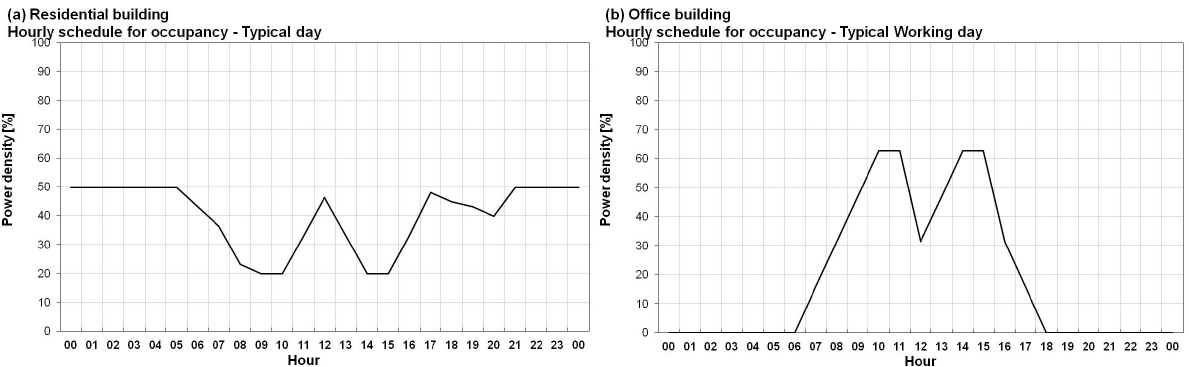
Figure 6. Specific hourly occupancy schedules for ( a ) residential building and ( b ) office building. Minimum, average and maximum